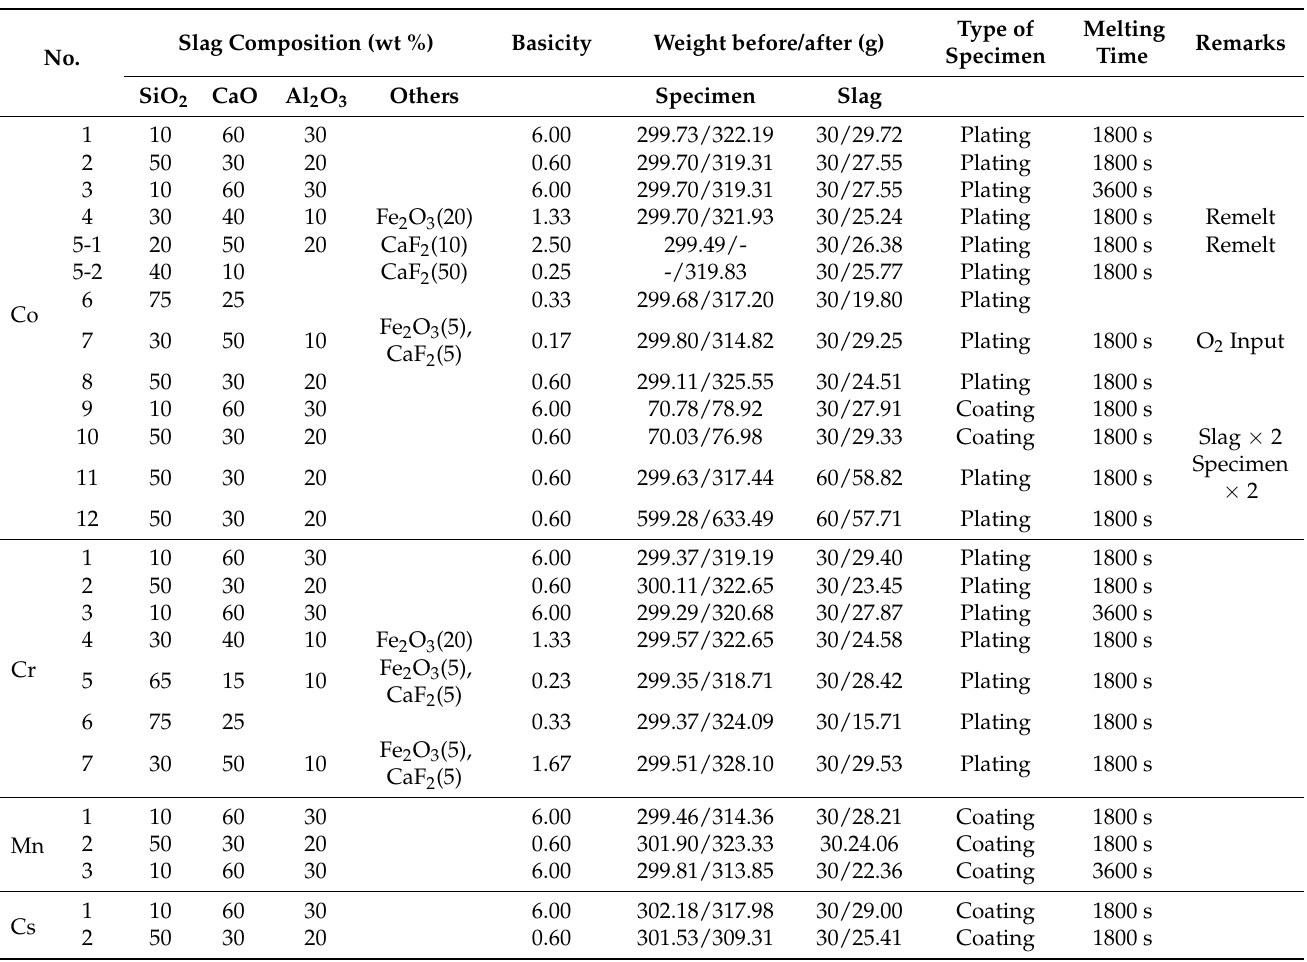
Table 3. Experimental conditions and weight change for